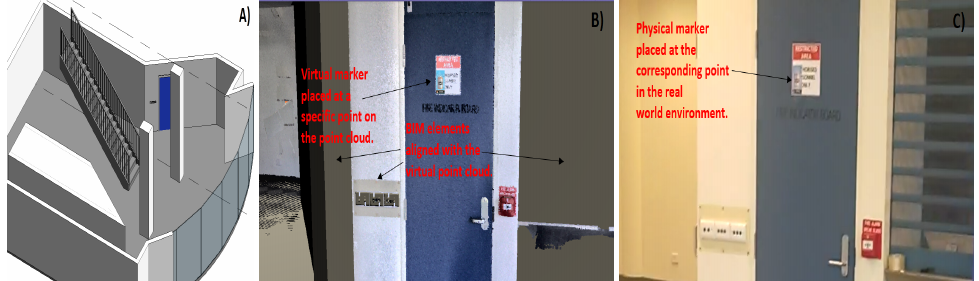
Figure 9. This diagram shows the basic calibration setup. The left image ( A ) shows the BIM model of the real-world building. Image ( B ) shows the BIM model superimposed onto the virtual point cloud. Image ( C ) shows the physical marker placed at the corresponding position of the virtual marker within the real-world environment.